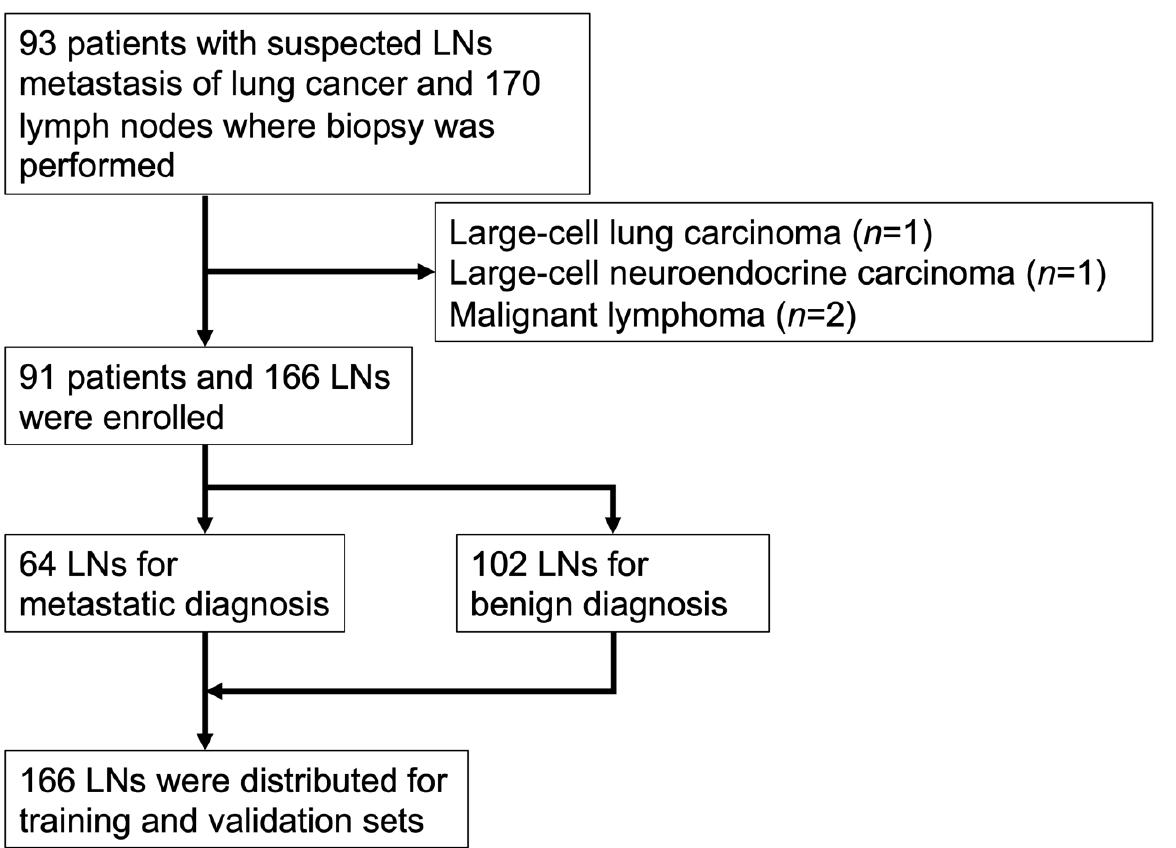
Figure 2. Study cohort flow chart. One hundred sixty-six lymph nodes and 6444 images from 91 patients were enrolled in the final